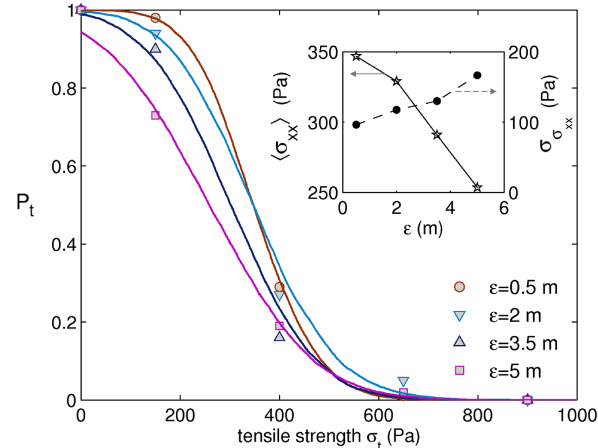
Figure 2. Probability of slab tensile failure P t within the simulated system (partial-slope release) as a function of the tensile strength σ t for different values of the correlation length (cid:15) , a coefficient of variation CV = 0 . 3, a constant slab thickness D = 1m, slab density ρ = 250kgm − 3 and Young’s modulus E = 1MPa. In the inset, the average tensile stress (cid:104) σ xx (cid:105) (solid line) and its standard deviation σ (dashed line) are represented as a function of (cid:15) σxx